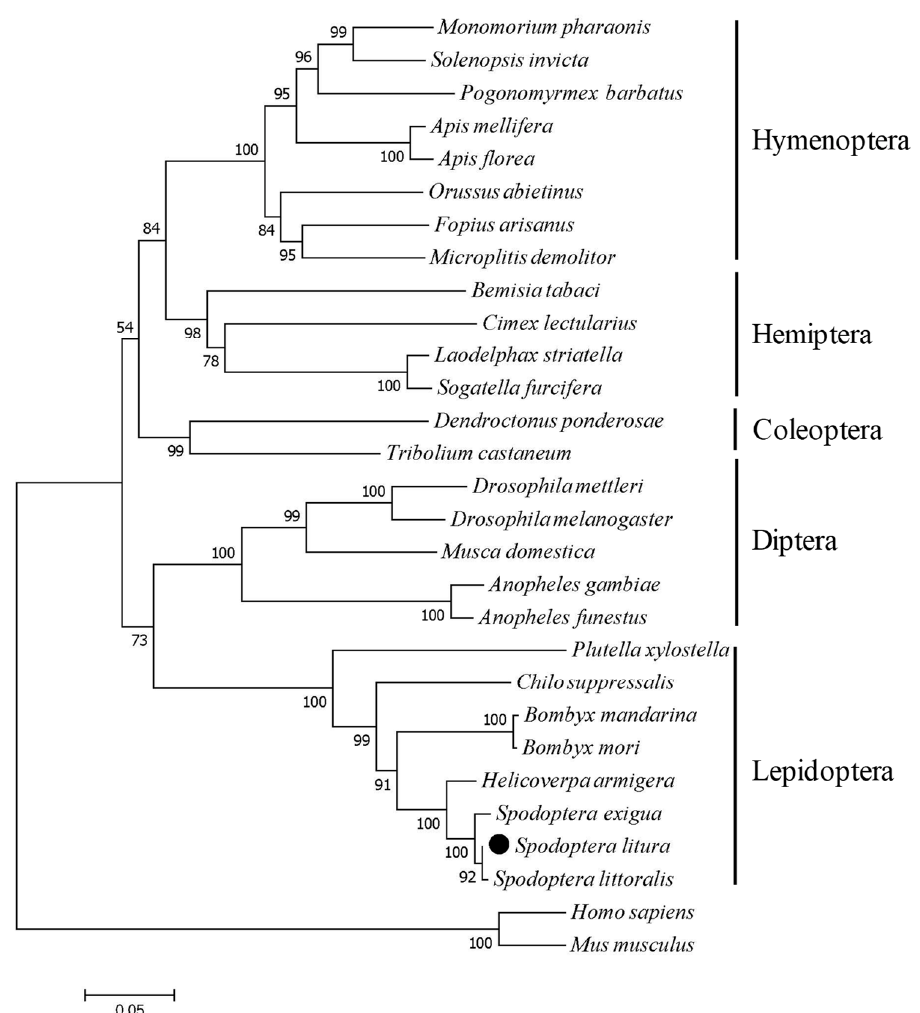
Figure 2. Phylogenic analysis of SlCPR and related insect CPRs. Multiple sequence alignment of full-length amino acid sequences of 29 CPR proteins was performed with DNAMAN 6.0 software. The phylogenetic tree was constructed using MEGA7.0 with the neighbor-joining (NJ) method and 1000 bootstrap replicates. Numbers shown at the tree forks indicate frequency of occurrence among all bootstrap iterations performed. The scale bar indicates 0.05 amino acid substitutions per site. CPRs from human and mouse were used as an outgroup. SlCPR is marked by a black solid circle. Accession numbers of indicated CPR amino acid sequences are shown in Table 1. Table 1. Percent amino acid identities between SlCPR and other CPRs.